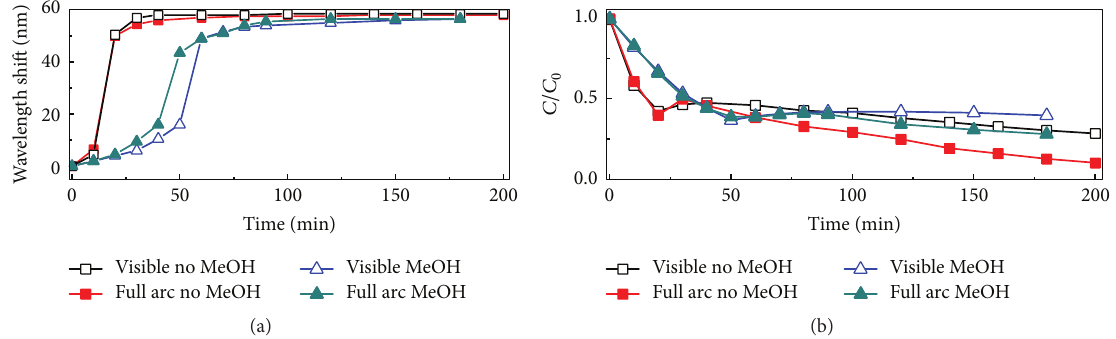
Figure 8: Variation in 𝐶/𝐶 0 (b) and wavelength shift (a) over A with and without methanol under full arc and visible light irradiation of Xe